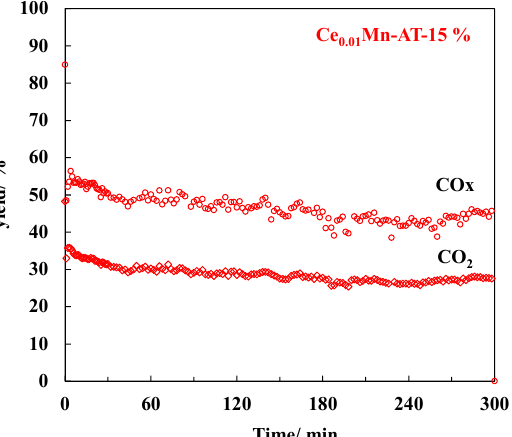
Figure 11. CO x and CO 2 yields obtained for TCE abatement (RH = 15%) in the PPC configuration with Ce 0.01 Mn-AT as the catalyst.